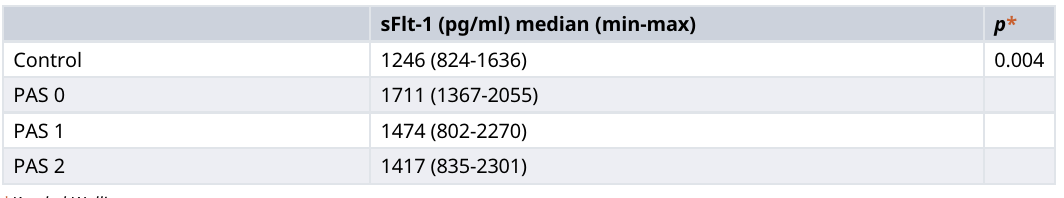
Table 2. sFlt-1 analysis based on PAS.